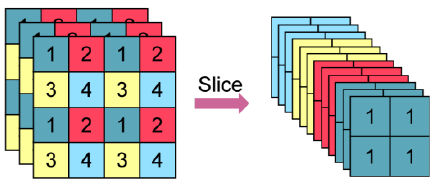
Figure 6. Structure of Slice. (1–4: pixel blocks).